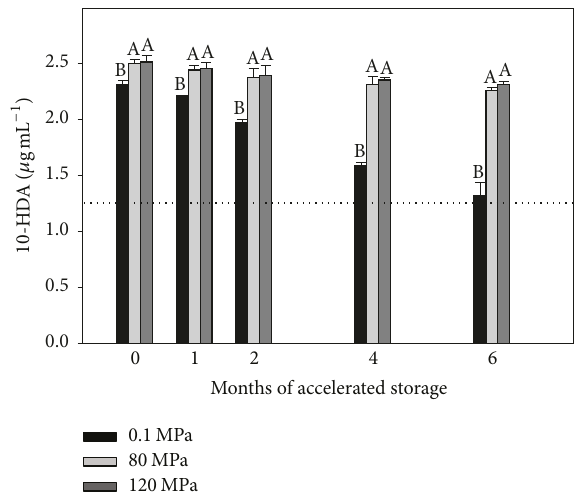
Figure 6: Effect of HPH treatments on the 10-HDA content of the royaljellyfoodsupplementstoredat40 ∘ C ± 2 ∘ Cand75% ± 5%RH. Mean ( 𝑛 = 3 ± SD). Different letters within the same day indicate significant differences between pasteurization and HPH treatments at 𝑝 ≤ 0.05 . ns: not significant. The dotted line indicates 50% 10- HDA losses with respect to the initial contents shown in Table